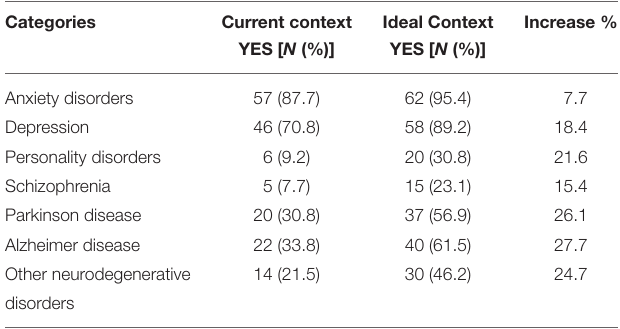
TABLE 8 | Self-assessment of GPs abilities to provide care for different categories of mental health problems in the current context and in an ideal context.